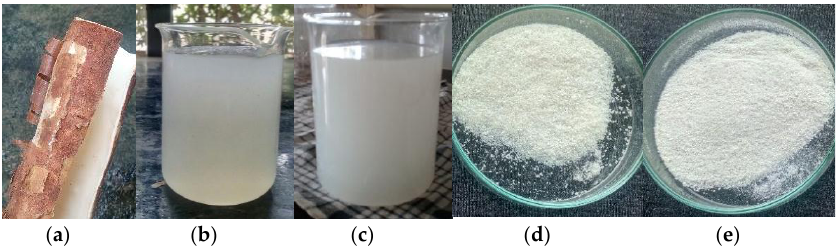
Figure 1. ( a ) Untreated CP, ( b ) CNF procedure I colloid, ( c ) CNF procedure II colloid, ( d ) CNF procedure I powder, and ( e ) CNF procedure II